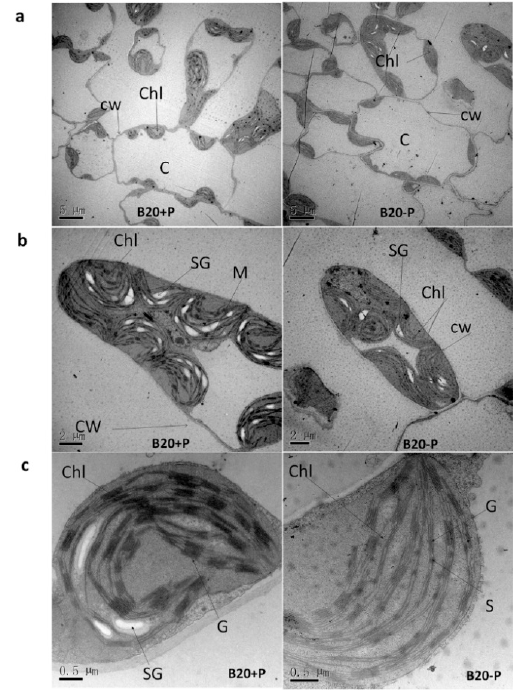
Figure 2. Electron micrographs of leaf mesophyll of soybean grow under low-P condition ( − P, 5 μ mol KH 2 PO 4 ) and control (optimum P, 1000 μ mol KH 2 PO 4 ). ( a – c ) Changes in organelles at different scales in 5, 2, and 0.5 μ m, respectively. Chl: chloroplast; C; cell, CW: cell wall; SG: starch granule; M: mitochondrion; G: grana; S: stenotrophomonas granule.